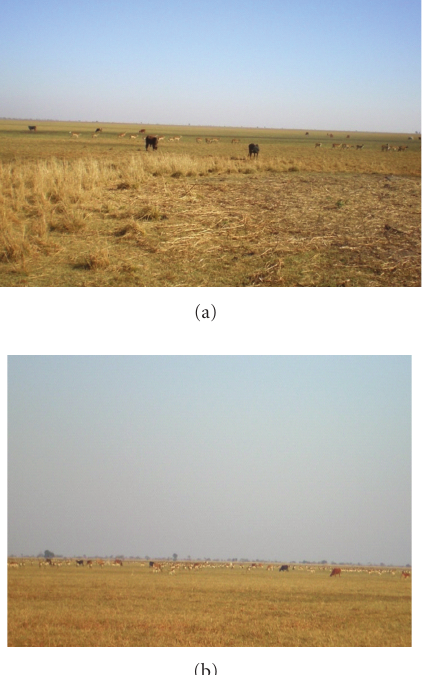
Figure 5: Lechwe antelopes and cattle grazing together in the Game Management Areas of Lochinvar National Park of the Kafue basin (left picture indicates the Eastern Game Management Area, whilst the right picture indicates the Western Game Management